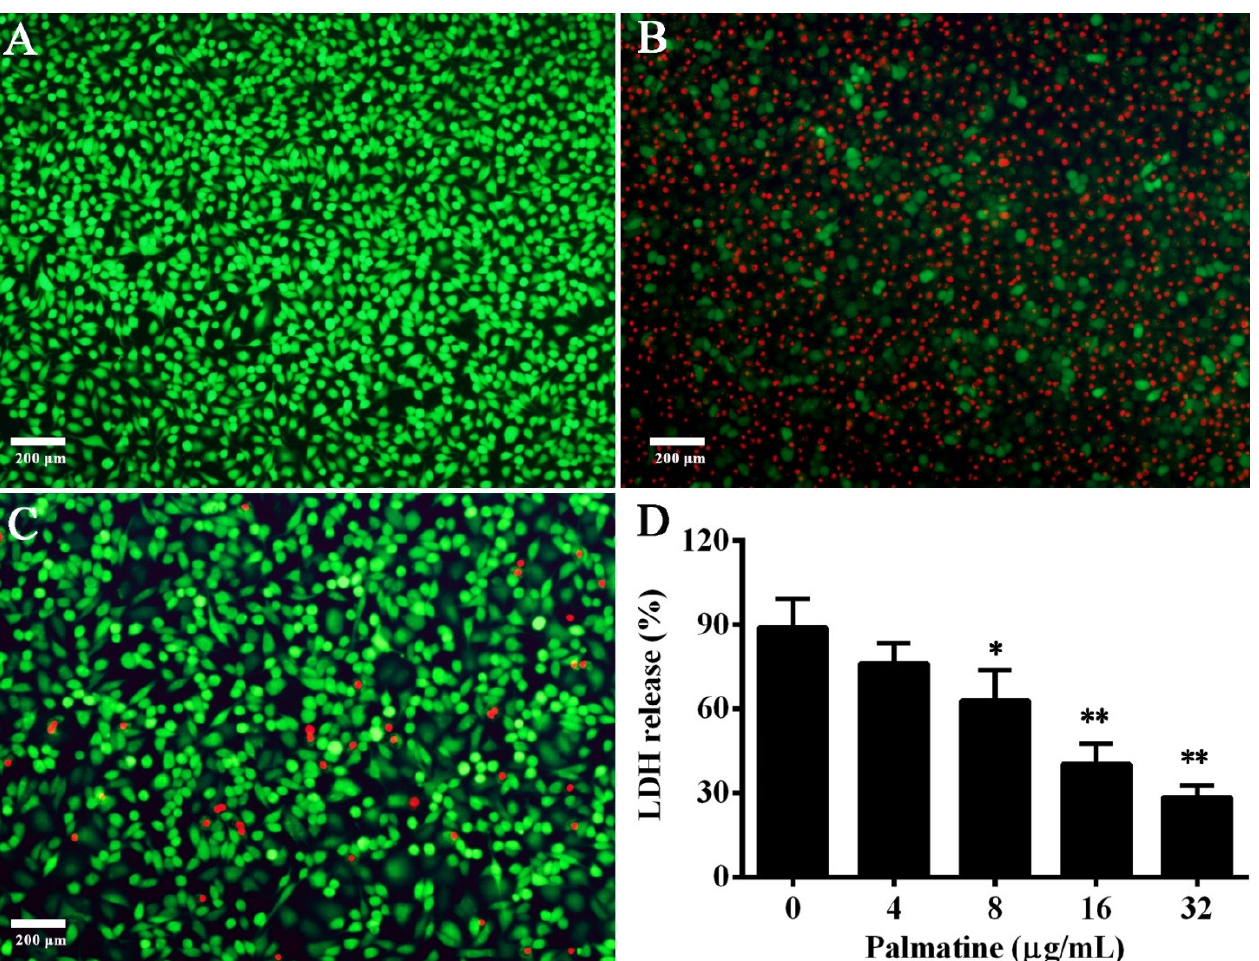
Figure 4. Palmatine reduced aerolysin-mediated cell injury. Cell viability was analyzed by live/dead staining regents, and pictures were captured by a fluorescence microscope; cell supernatants were used for evaluating cell injury by LDH release assay. ( A ) Untreated A549 cells. Most cells were alive and were stained with green. ( B ) Cells treated with bacterial supernatant without palmatine. Most cells were dead and were stained with red. ( C ) Cells treated with bacterial supernatant treated with 32 μ g/mL palmatine. ( D ) LDH release of A549 cells after being co-cultured with bacterial supernatants treated with indicated concentrations of palmatine. Data of LDH release assay were the mean ± SD for three independent assays; * indicates p < 0.05, ** indicates p < 0.01.